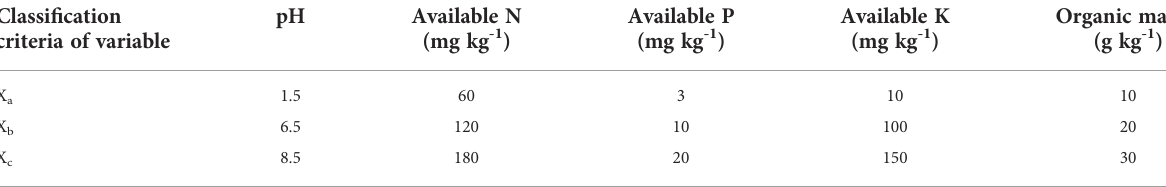
TABLE 3 Classi fi cation values for nutrients in soils at different classi fi cation criteria. Classi fi cation pH Available N Available